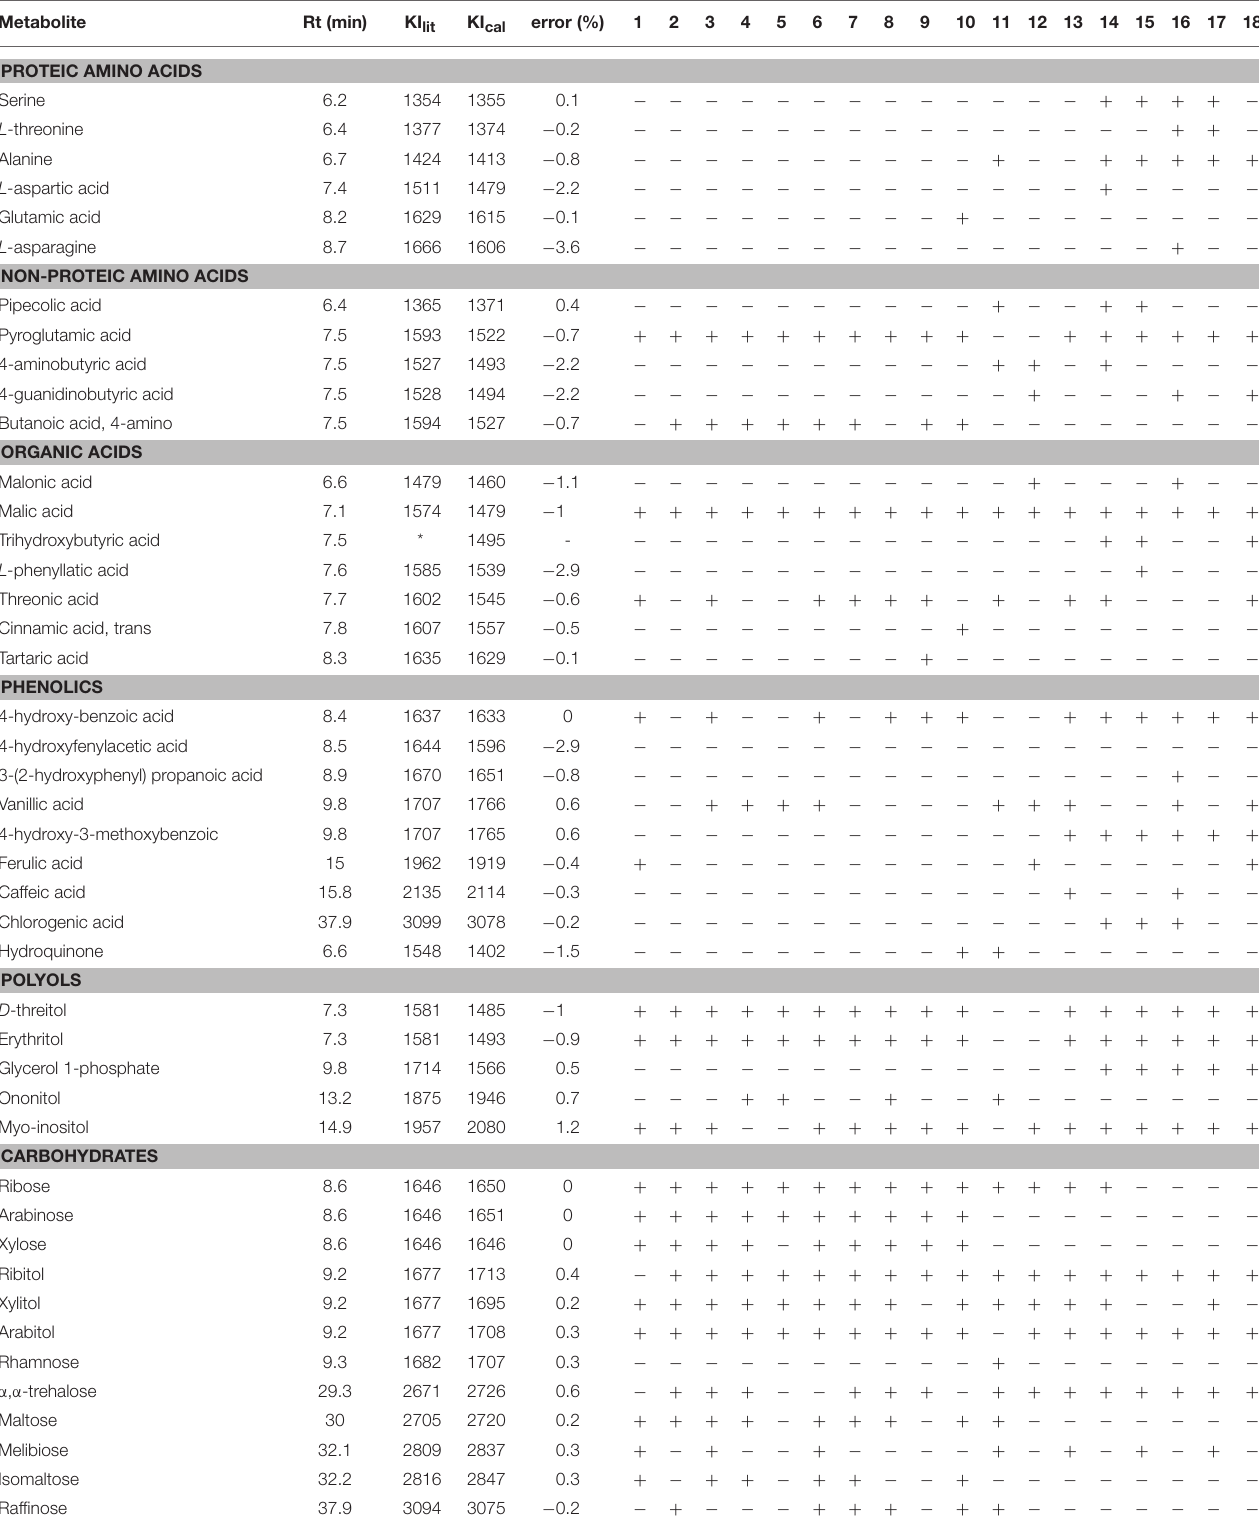
TABLE 3 | Metabolites detected by GC-MS using AMDIS-RAMSY deconvolution.